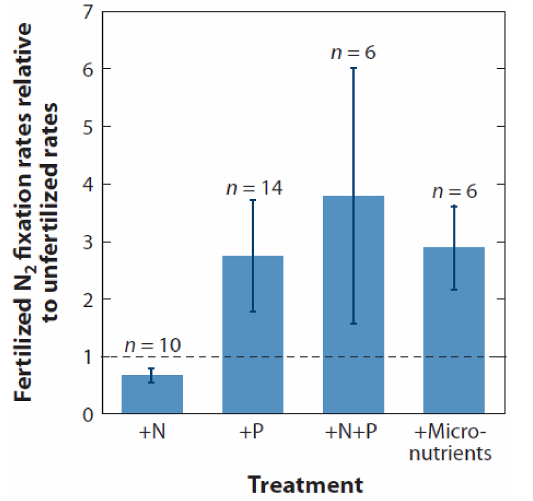
Figure 3. Response of free-living N fixation rates to different nu- trient fertilization treatments. Values above 1 on the y axis indicate positive response, while those below indicate a negative response to fertilization by + N, + P, + N + P, or + micronutrients (from Reed et al.,